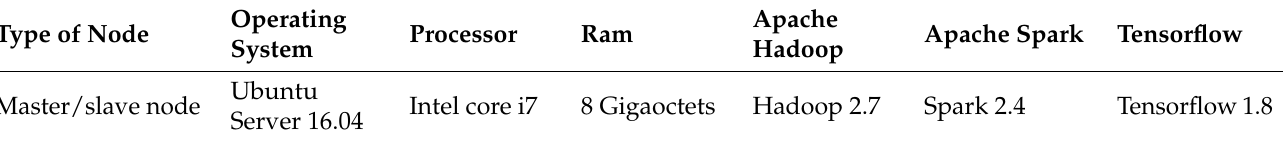
Table 1. configuration of the distributed local